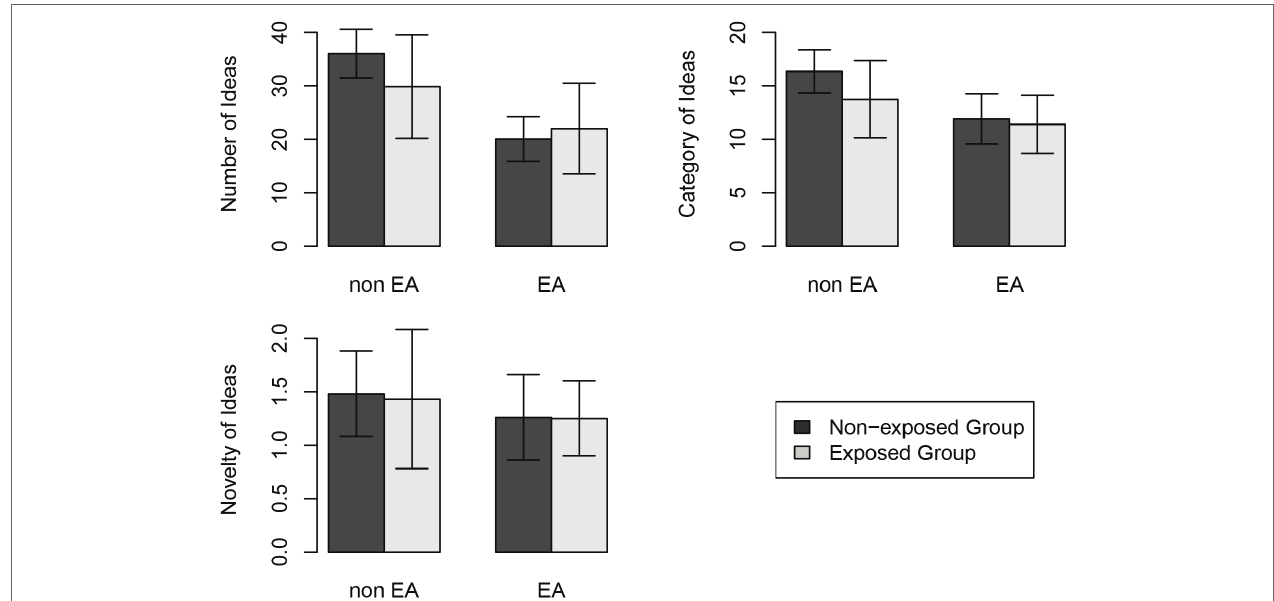
FIGURE 1 | Group idea generation under four conditions (the error bars refer to standard